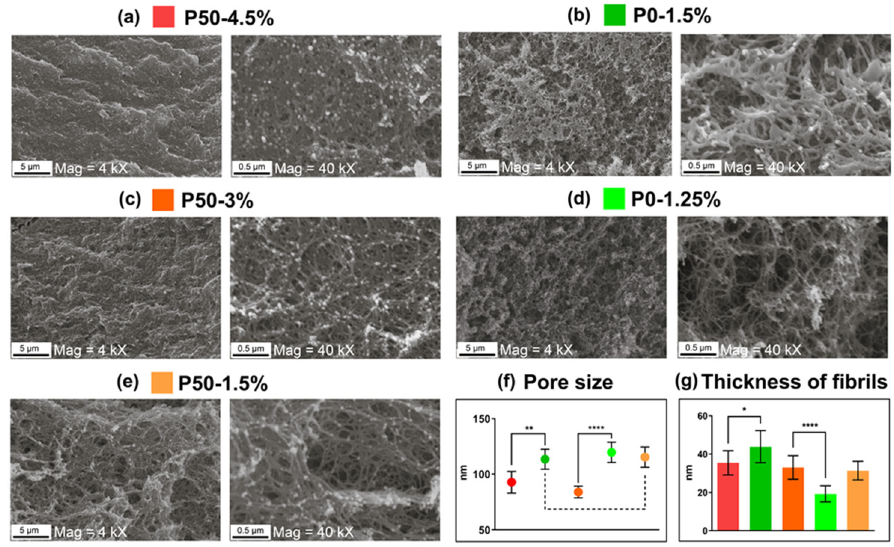
Figure 5. SEM of pectin hydrogels at magnifications of 4 kX and 40 kX: ( a ) P50-4.5%; ( b ) P50-3%; ( c ) P50-1.5%; ( d ) P0-1.5%; ( e ) P0-1.25%; ( f ) pore size; ( g ) fibril thickness, n = 100, * p < 0.05, ** p < 0.01, **** p < 0.0001.